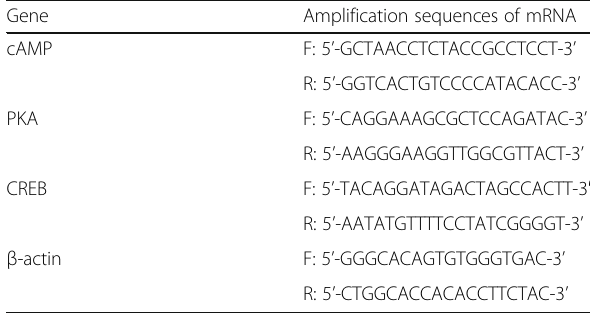
Table 1 The primer sequences of mRNA Gene Amplification sequences of